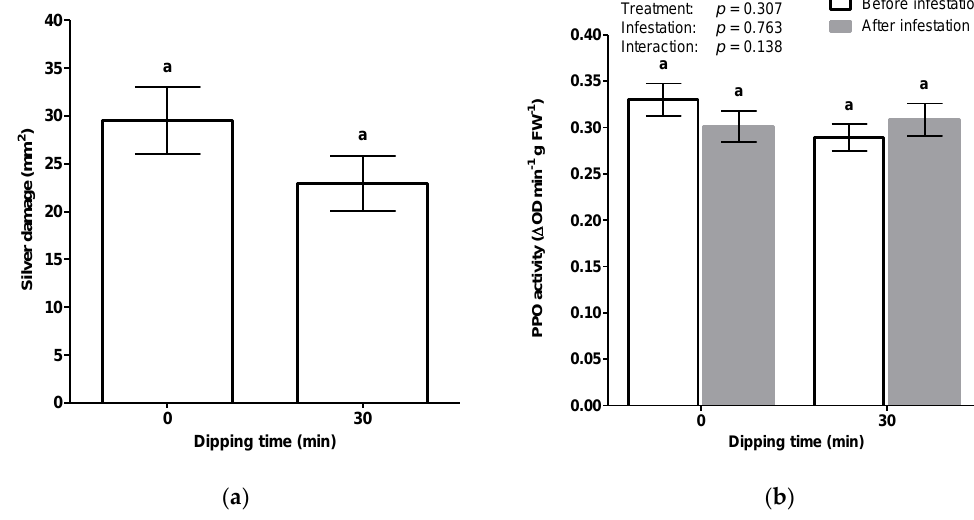
Figure 5. Effect of water dipping treatment on thrips-associated feeding damage ( a ) and polyphenol oxidase (PPO) activity ( b ). Cut ends of chrysanthemum cultivar Baltica, precoated with the powder formulated rooting hormone IBA (Chryzotek beige 0.4%), were dipped in water for 30 min. Two weeks post treatment, cuttings were infested with 20 adult thrips or sampled for PPO measurements before infestation. One week after thrips infestation, silver damage symptoms were visually scored and expressed as damaged leaf area in mm 2 and subsequently sampled for PPO activity after infestation. Data in the graphs represent mean ± SEM of 20 individual cuttings. The main effects of dipping time, infestation and their interaction are indicated in the graph.